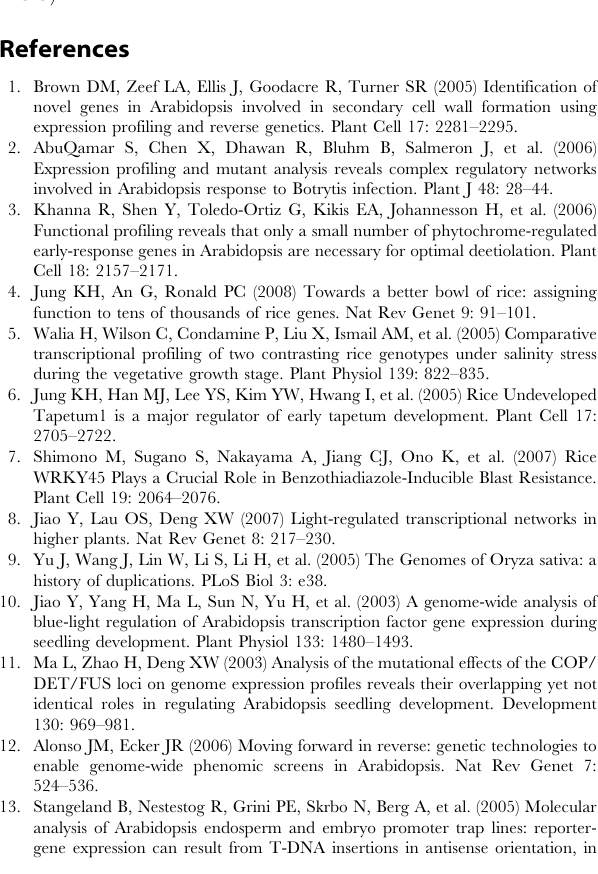
Table S4 Microarray Data Displayed in Figure 4.